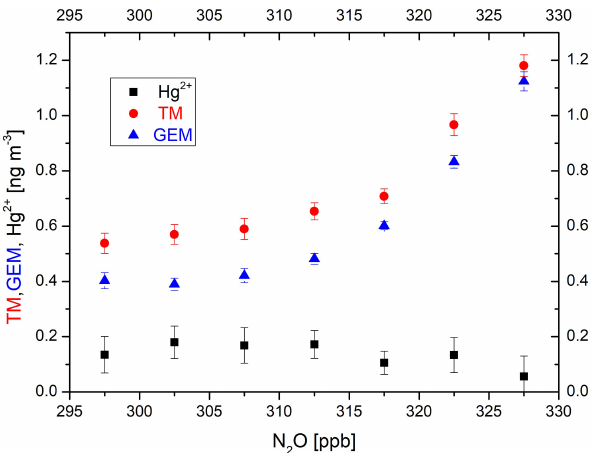
Figure 7. Stratospheric average TM and GEM concentrations in boreal winter (November–April) are binned according to the N 2 O mixing ratio. N 2 O mixing ratios were detrended using 2015 as a ref- erence year and the N 2 O growth rate of 0.844ppbyr − 1 (Assonov et al., 2013). Vertical and horizontal bars represent the standard errors of the